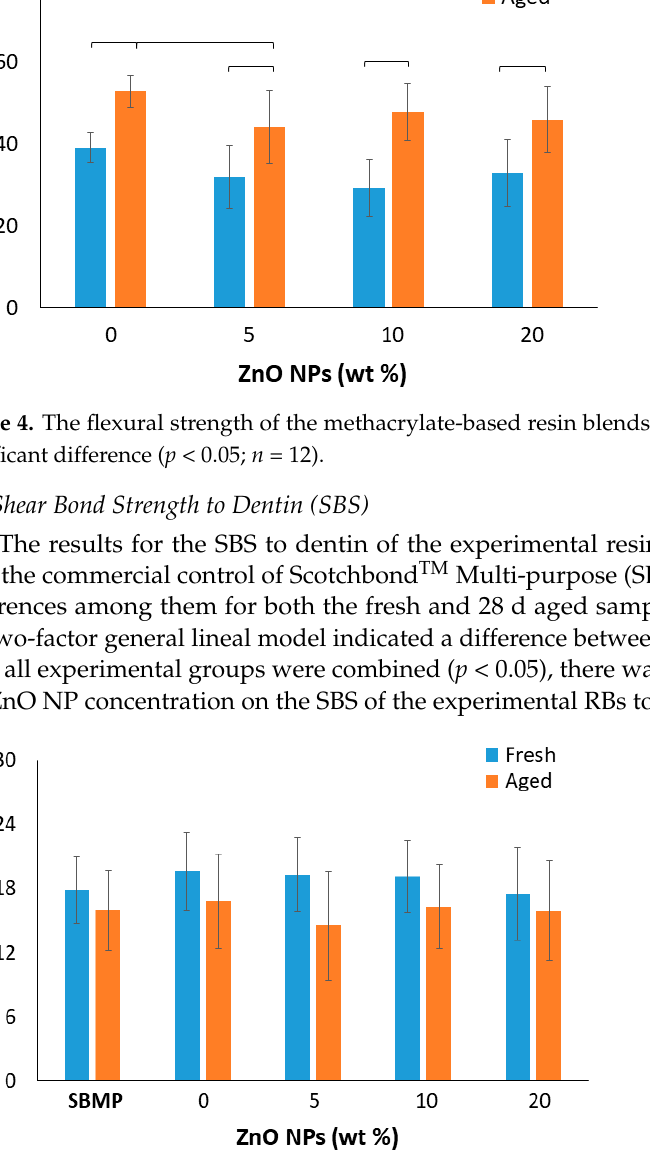
Figure 5. The shear bond strength (SBS) of the methacrylate-based resin blends ( n = 12).